Question: In one sentence, what is this figure communicating?
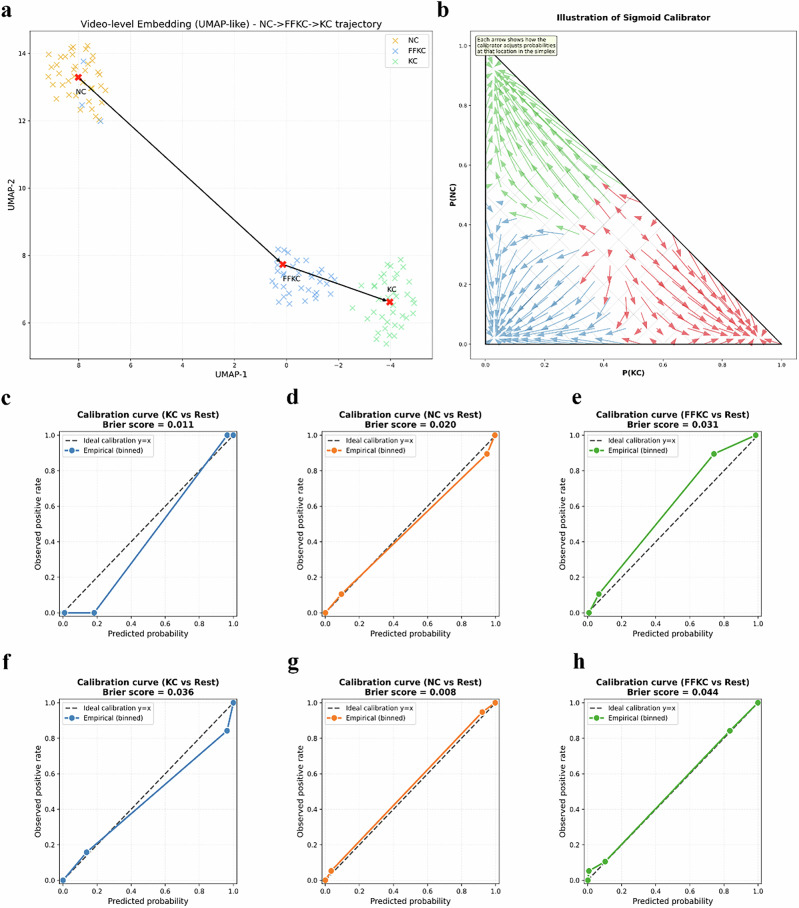
Answer: Biomechanical progression trajectories, probability calibration, and reliability analysis. a UMAP embedding illustrating the clustering of NC/FFKC/KC and the biomechanical progression trajectory along the NC-FFKC-KC axis; b Schematic illustration of the sigmoid calibrator in the three-class probability simplex, with arrows indicating the direction and magnitude of how the calibrator maps raw predicted probability vectors to calibrated probability vectors; c – e One-vs-rest calibration curves for the three classes in the test set; f – h One-vs-rest calibration curves for the three classes in the validation set.